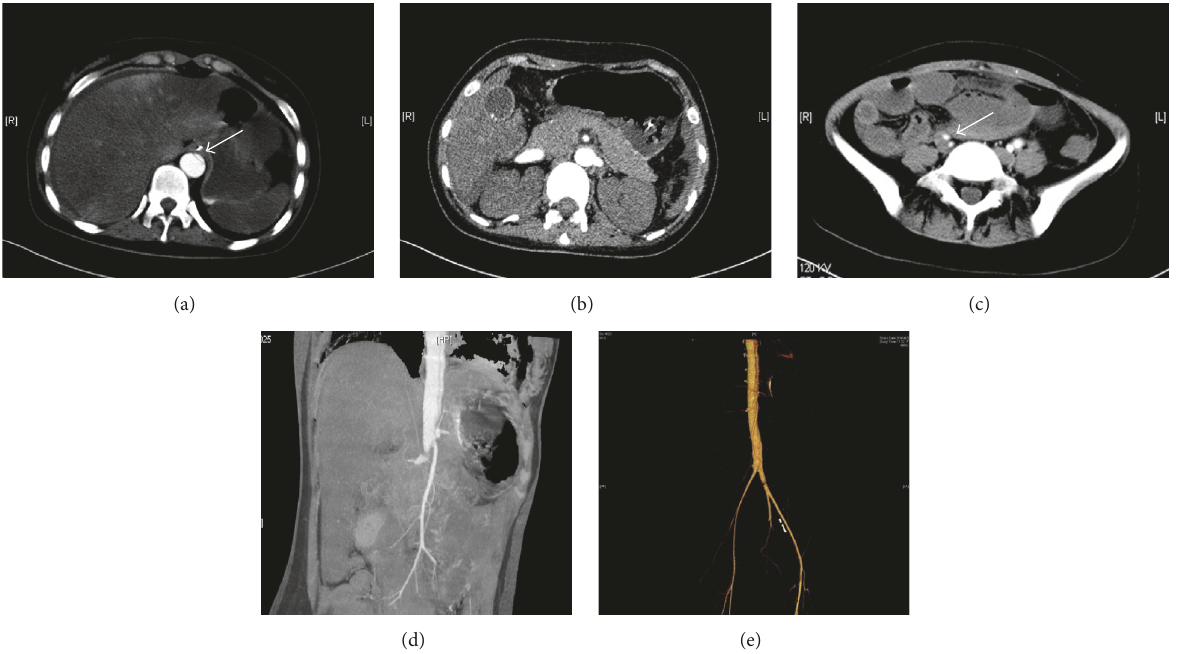
Figure 1: CTA images of aortic dissection. (a) CTA image shows the true and false lumen of aortic dissection and abnormal perfusion of liver and spleen. (b) Decreased perfusion of bilateral kidneys. (c) Abnormal right internal and external iliac arteries. (d and e) 3D reconstruction of CTA images.